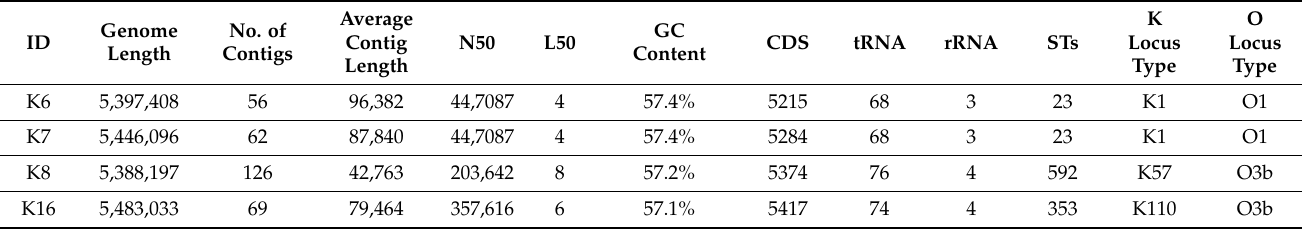
Table 2. Genomic features and assembly